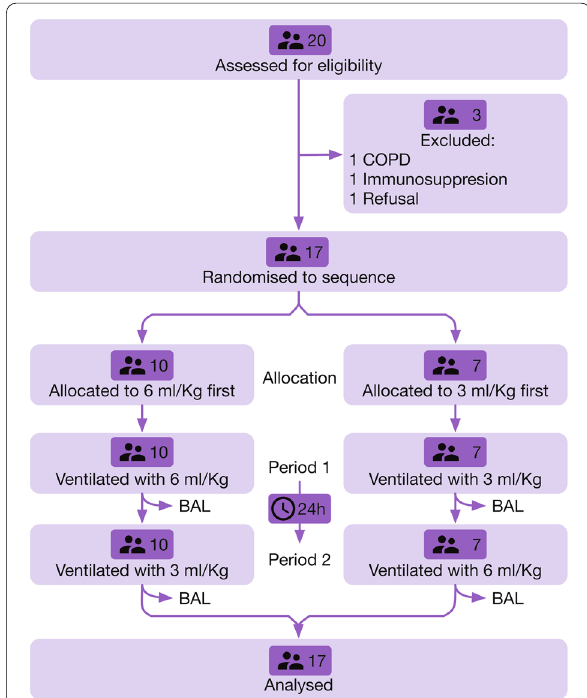
Fig. 1 CONSORT flow diagram of the study. COPD chronic obstructive pulmonary disease, BAL bronchoalveolar lavage